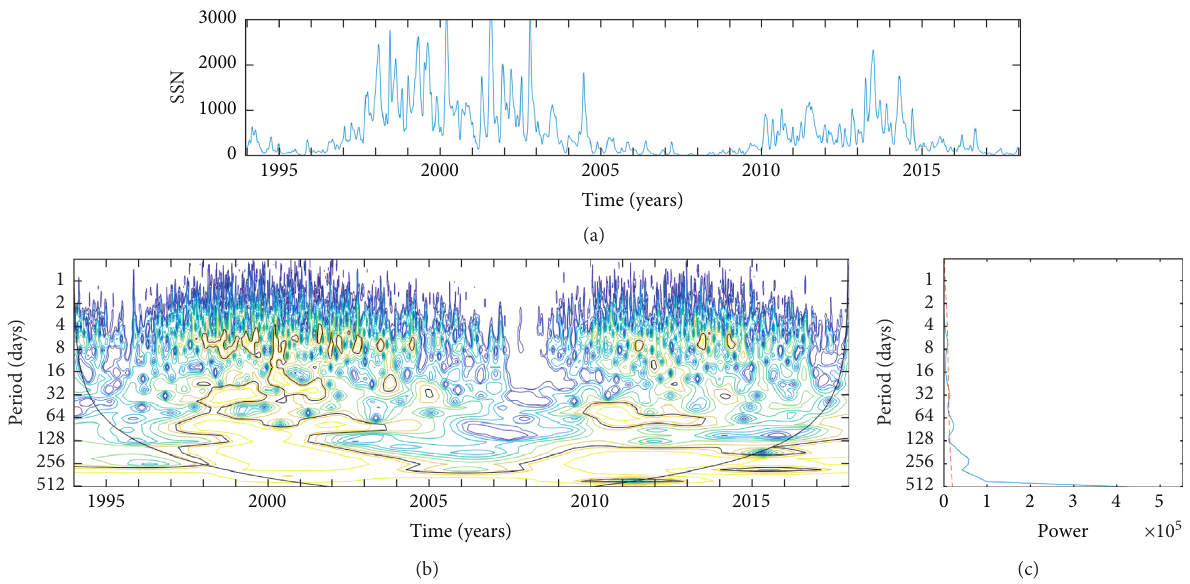
Figure 6: (a) The scale-average time series of daily sunspot numbers, (b) the wavelet spectrum, and (c) the global wavelet